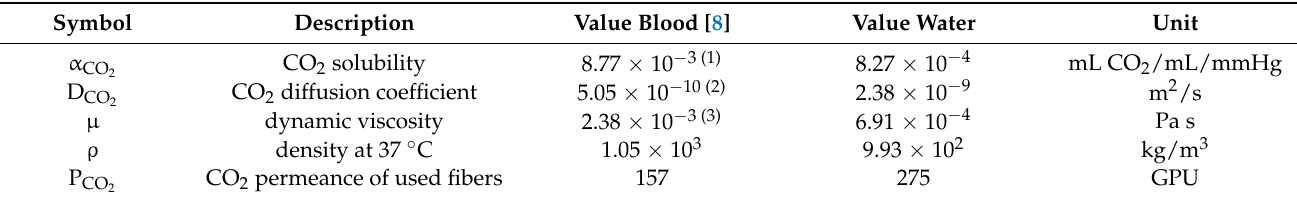
Table 4. Comparison of parameter values for blood and water used in CO 2 transport